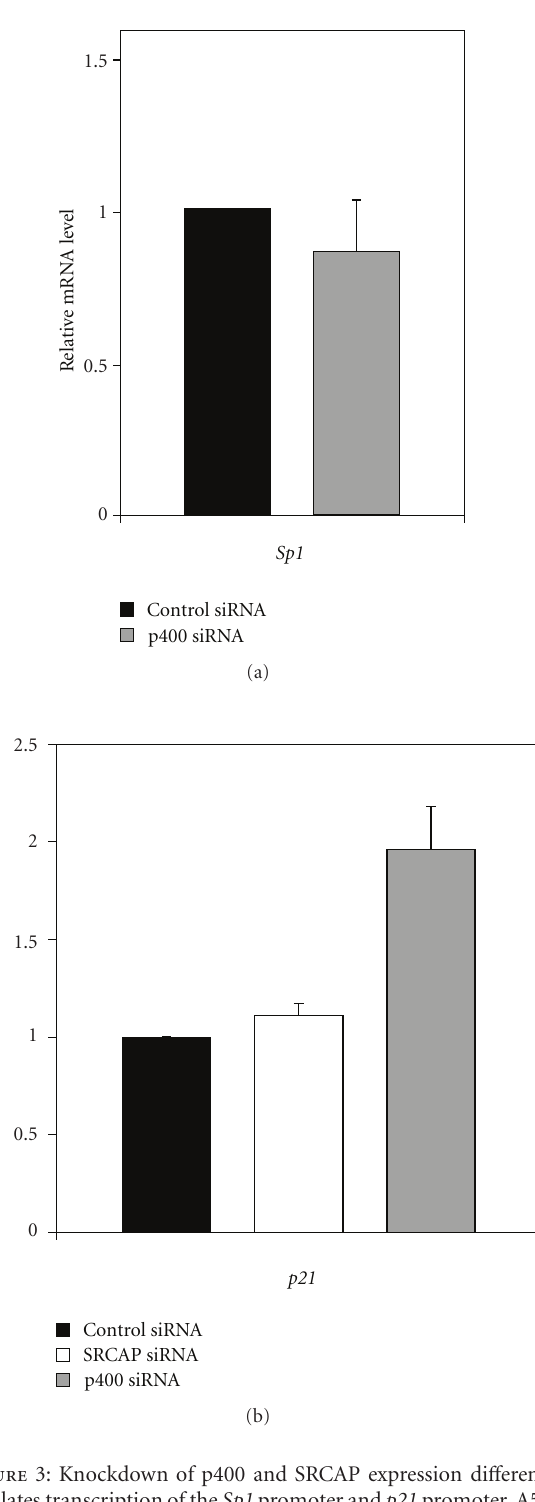
Figure 3: Knockdown of p400 and SRCAP expression di ff erently regulates transcription of the Sp1 promoter and p21 promoter. A549 cells were transfected where indicated with control, SRCAP or p400 siRNA, harvested 72 hours later and total RNA isolated. In (a), the level of Sp 1 mRNA was assessedusing RT-qPCR using primers listed in [3]. In (b), the level of p21 mRNA was determined by RT-qPCR using primers listed in Table S1(a). The graphs show the mean result and standard error from three experiments.